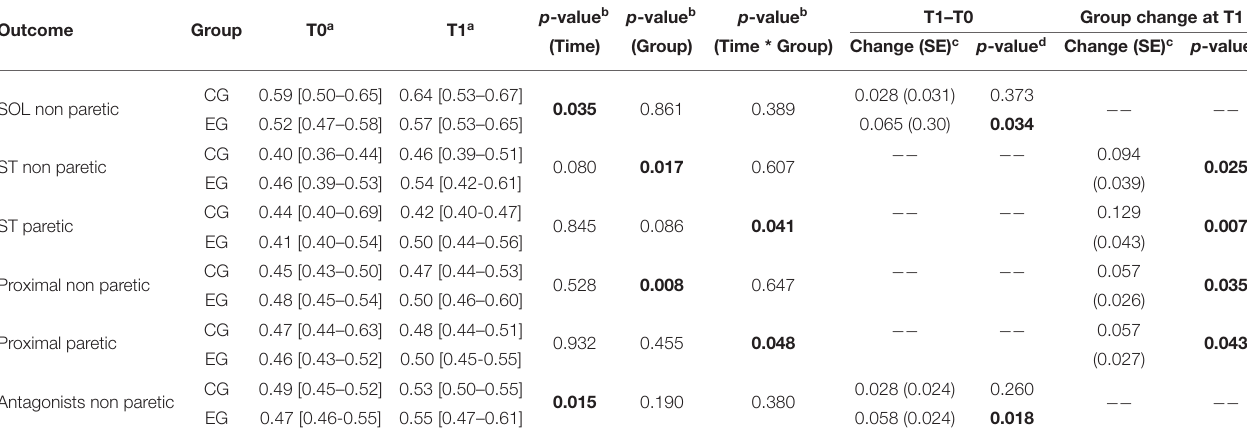
TABLE 3 | Changes over time and between group for gait metric ( N = 29).